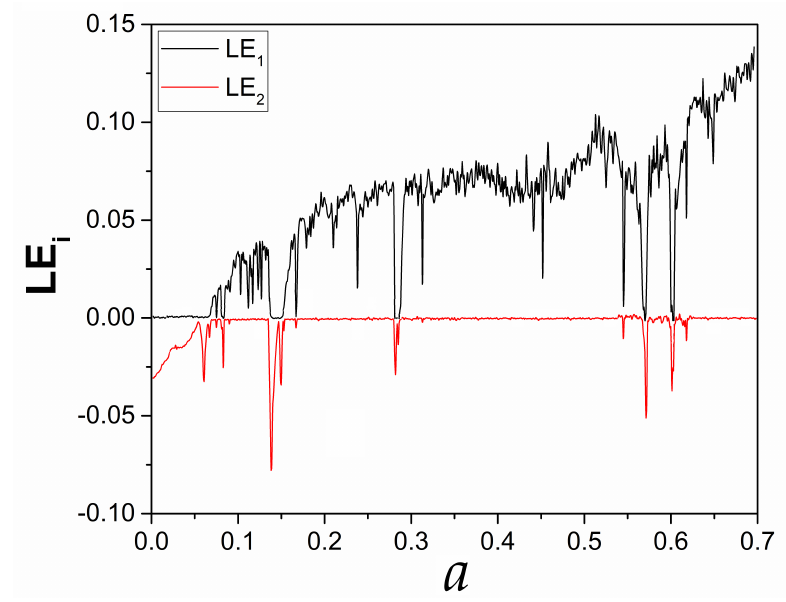
Figure 8. Diagram of the two largest Lyapunov exponents with respect to parameter a , for b =